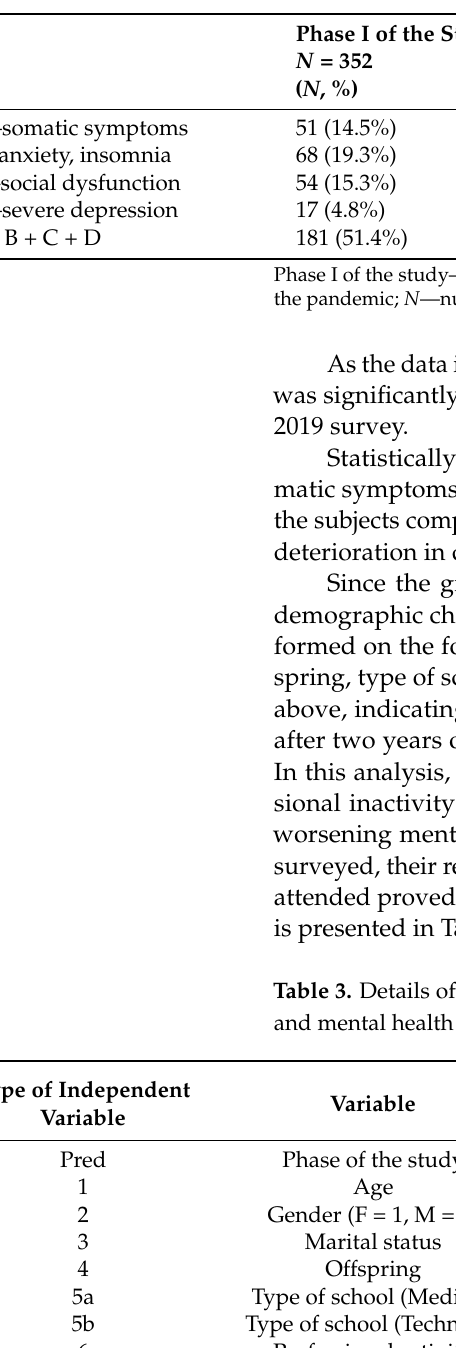
Table 2. Number and percentage of the study participants showing 5 and more points in each of the GHQ-28 scales.